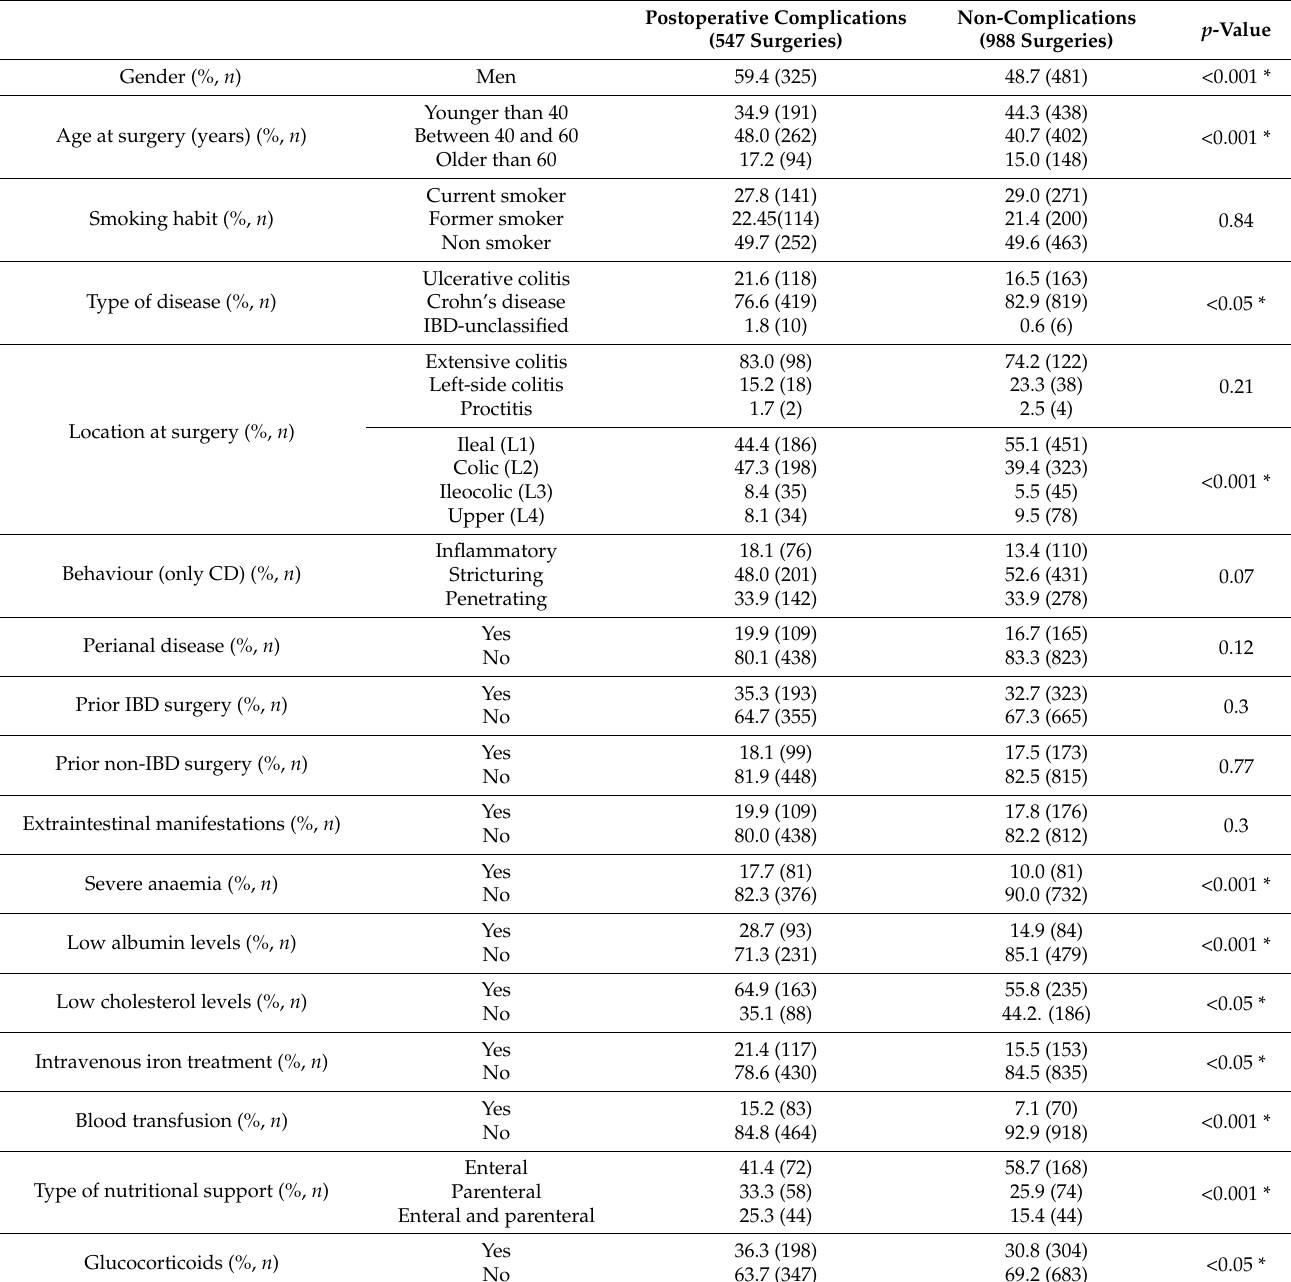
Table 3. Clinical and therapeutic features related to the presence of postoperative complications. p -values were calculated by Chi-square test, t -test or Wilcoxon-rank